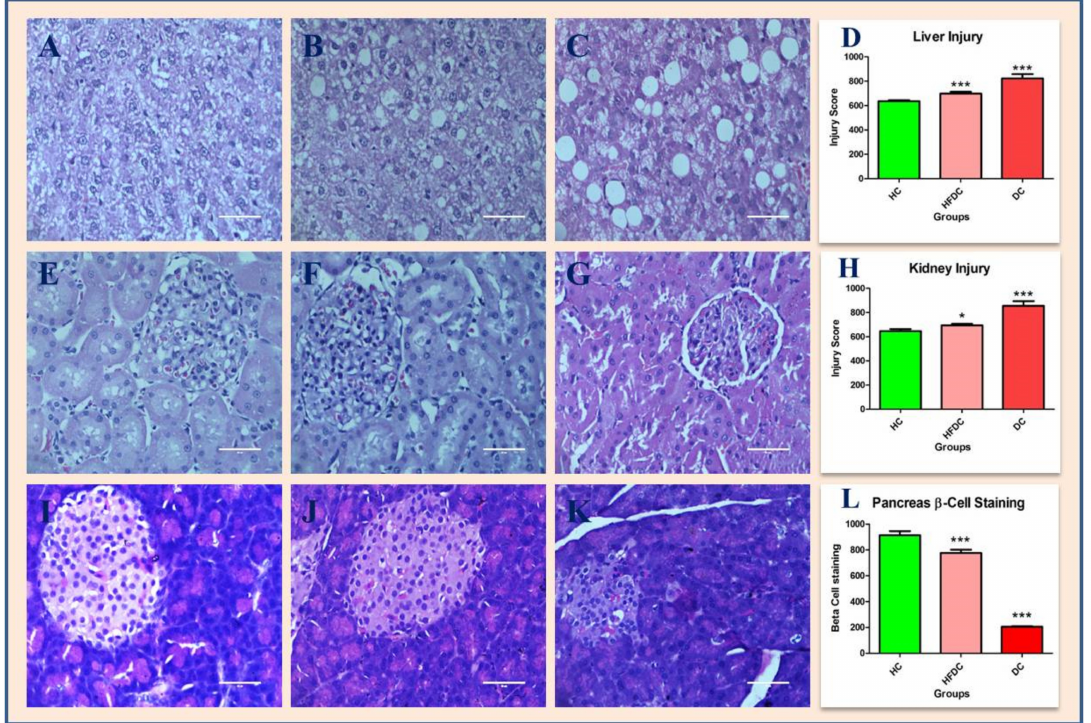
Figure 6. Histopathological examination of liver, kidney and pancrease tissues (40 × , Scale bar = 50 µ m). Histology of liver of healthy control ( A ), High fat diet ( B ), Diabetic control ( C ) and Liver injury ( D ); kidney of healthy control ( E ), High fat diet ( F ), Diabetic control ( G ) and kidney injury ( H ) and pancrease of healthy control ( I ), High fat diet ( J ), Diabetic control ( K ) and Beta cell staining. Tissue injury and beta cell staining data graphically expressed as mean ± SD and compared using Dunnett’s multiple comparison test against a healthy control (* p ≤ 0.05 and *** p ≤ 0.001) ( D , H , L